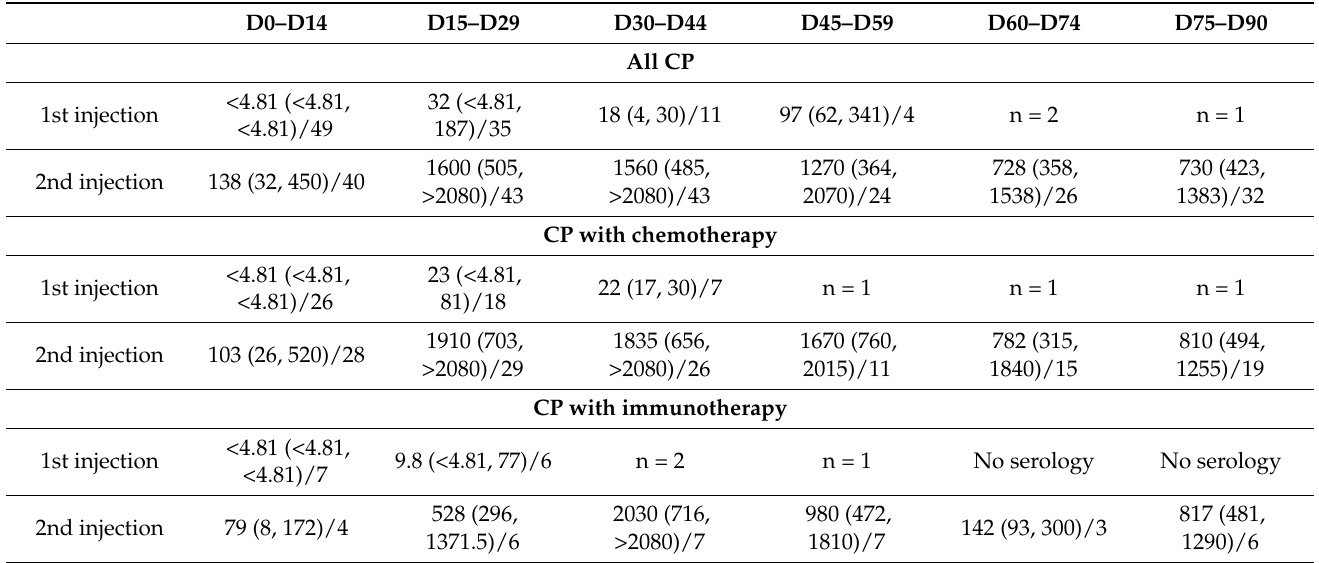
Table 2. Results of antibody response following vaccination in Cancer Patients: titer of neutralizing antibodies expressed as median (25th, 75th percentiles) (in BAU/mL) according to participant characteristics (at baseline) and date of sample collection regarding the vaccine